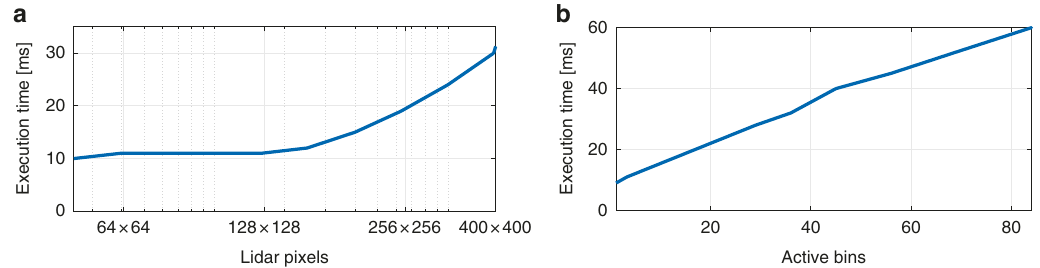
Fig. 5 Execution time of the proposed method. The execution time is shown as function of a lidar pixels (having a mean of 4 active bins per pixel), and b histogram bins with non-zero counts, for an array of 141 ´ 141 pixels. As all the steps involved in the reconstruction algorithm can process the pixel information in parallel, the total execution time does not increase signi fi cantly when more pixels are considered. However, as the pixel-wise operations are not fully parallel, there is a linear dependency on the number of active (non-zero) bins present in the lidar frame